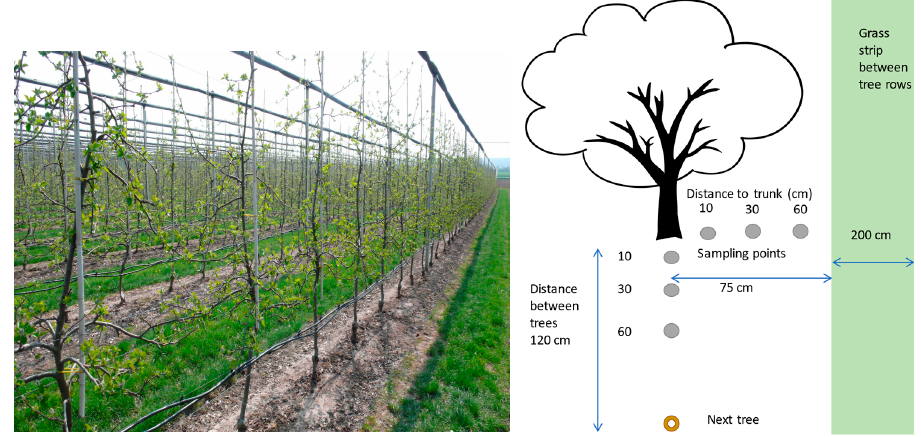
Figure 3. The scheme of the planting pattern, drip irrigation layout, and root sampling